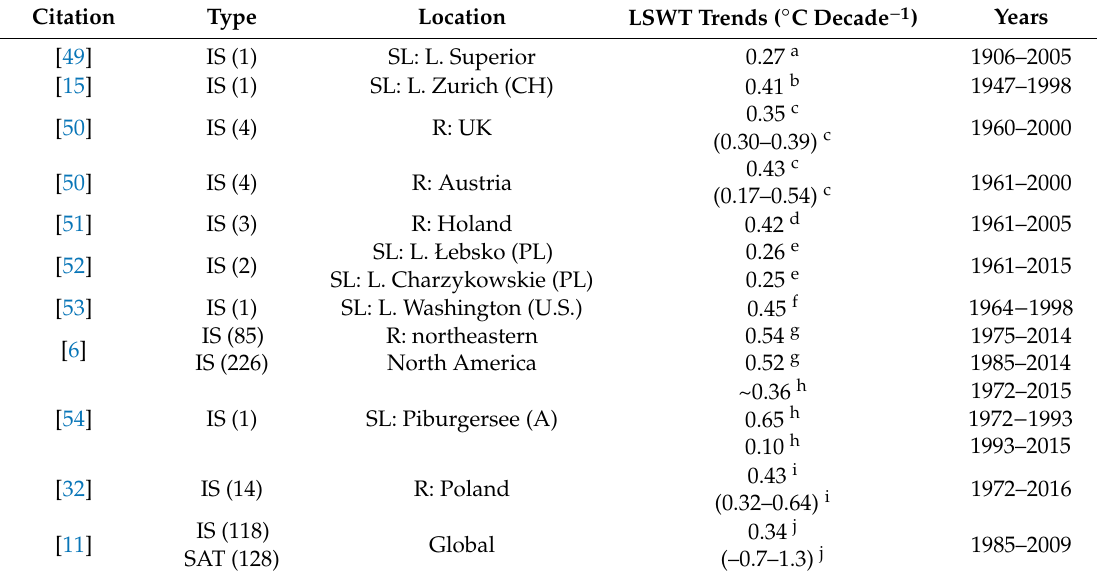
Table 1. Lake surface water temperature (LSWT) trends ranging from a global suite of lakes to a single lake. Presented trends are average or median (sometimes range) in ◦ C decade − 1 , unless otherwise noted. “Type” indicates how measurements were taken (“IS” = in situ, “SAT” = satellite). The number following in parentheses indicates the number of lakes included in the study. “Location” indicates if the study was global, regional (“R”) or single lake (“SL”), with the country code (A—Austria; CH—Switzerland; PL—Poland; U.S.—United States) and / or the lake name (studies on single lake).